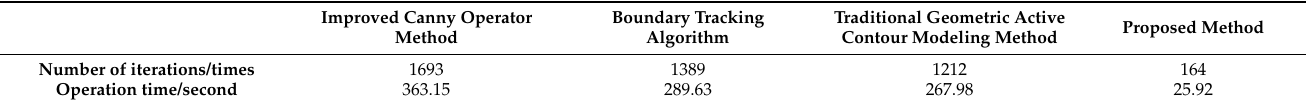
Figure 6. Shoreline extraction results: ( a ) Improved Canny operator method; ( b ) Boundary-tracking algorithm; ( c ) Traditional geometric active-contour modeling method; ( d ) Proposed method. Table 1. Algorithm extraction performance results. Table 2. Comparison of extraction efficiency of